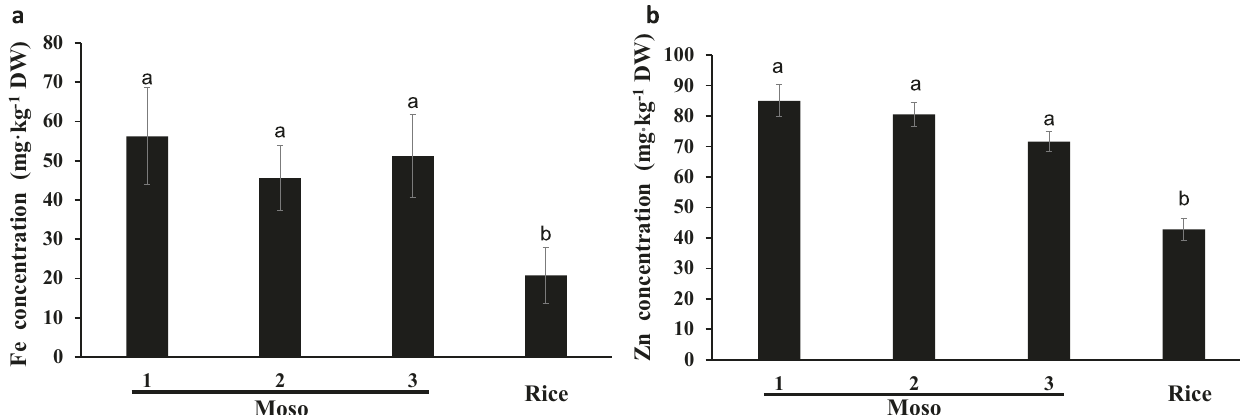
Fig. 1 Fe and Zn concentration in Moso bamboo seeds and rice. a Fe concentration in Moso bamboo seeds and rice. b Zn concentration in Moso bamboo seeds and rice. Seeds of Moso bamboo collected from three different geographical sits were named 1, 2, and 3, respectively. The concentration of Fe and Zn in bamboo seeds and rice was determined by ICP-MS. Data are means ± SD ( n = 3). Statistical comparison was performed by one-way ANOVA, followed by Tukey ’ s multiple comparison test. Different lower-case letters indicate signi fi cant difference at P <